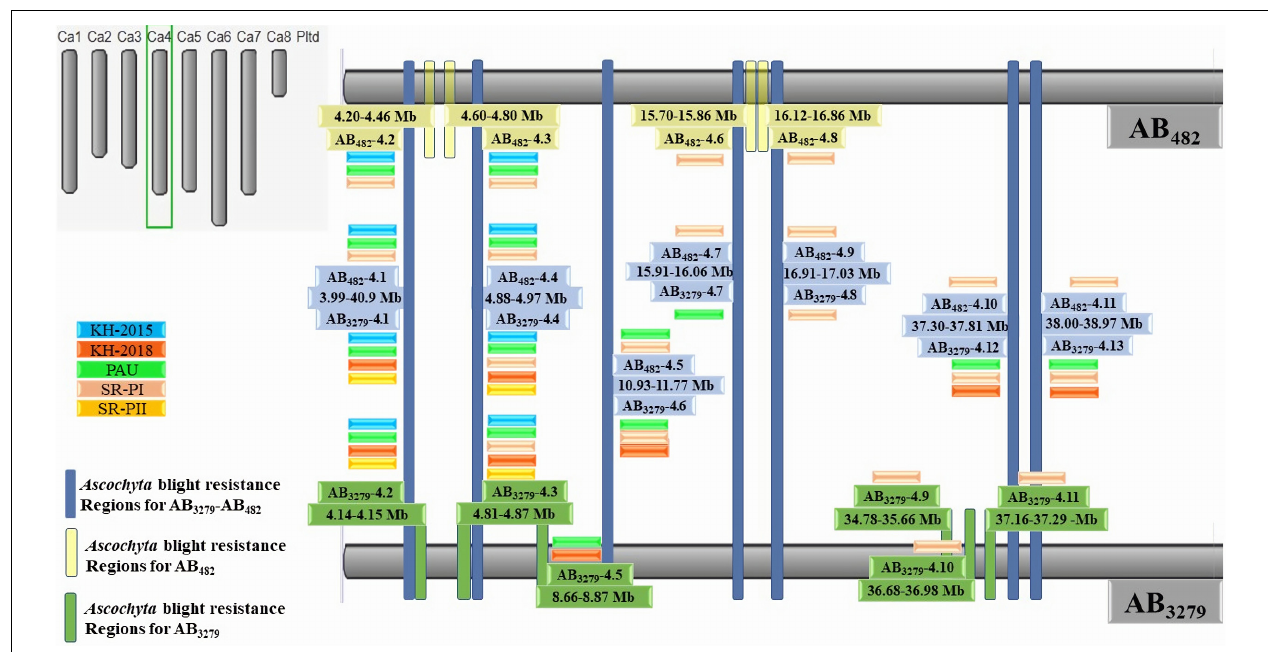
FIGURE 5 | High-density intraspecific genetic map of chickpea (ILC482 × ILC1929) using genotyping-by-sequencing (GBS)-SNP markers. Bars in dark blue color font are the common genomic regions in both populations AB 3279 and AB 482 , bars in yellow color font are genomic regions in AB 482 . Bars in green color font are genomic regions in AB 3279